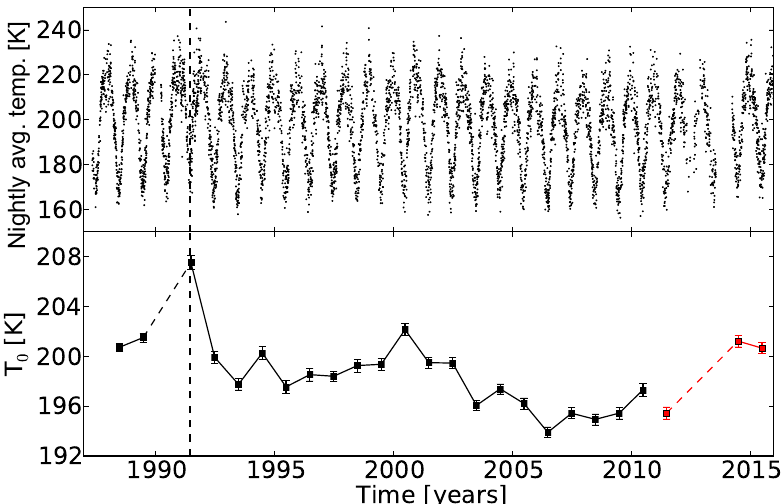
Figure 1. OH ∗ temperature time series derived from GRIPS-II and GRIPS-N measurements at Wuppertal. The upper panel shows the nightly average temperatures and the lower panel shows the annual average temperatures T 0 . Each T 0 is plotted in the middle of the corresponding year and the dates given at the x axis show the beginning of the years. The annual average temperatures partly or completely derived from the new instrument between 2011 and 2015 are shown in red in the lower panel. The error bars show the estimated 1 σ uncertainties σ T the temperatures T 0 (based on the standard deviation of the residuals). The vertical dashed line marks the date of Mt Pinatubo